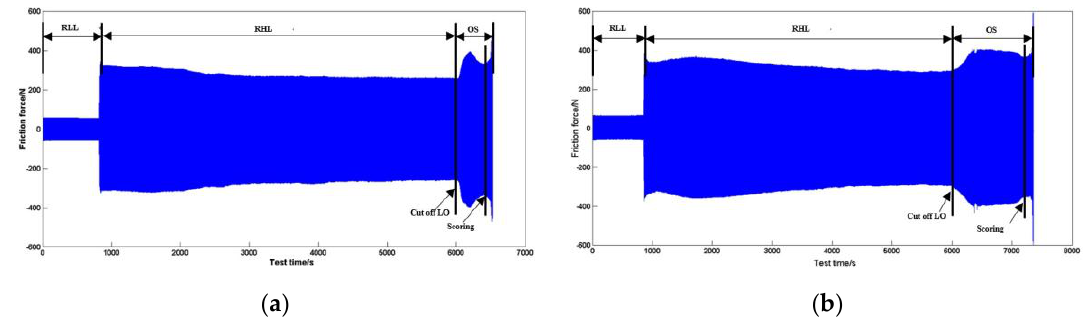
Figure 4. Friction force variation in the starvation experiment (60 MPa, 180 °C): ( a ) CKS ring; ( b ) NCM ring.